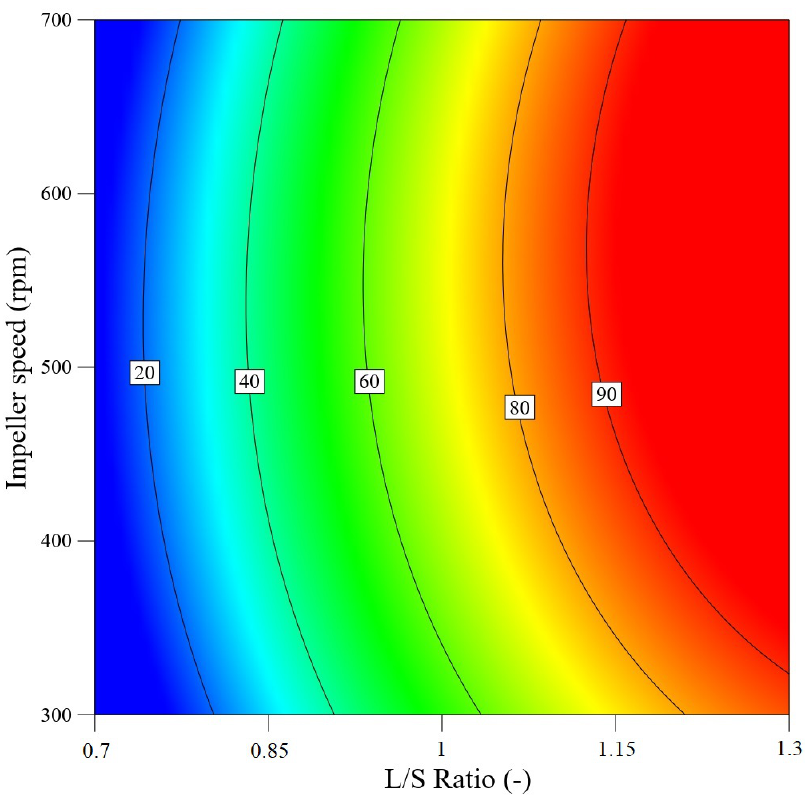
Figure 14. Contour plot of the quadratic model for prediction of the process yield as a function of L/S ratio and impeller speed. Table 3. Analysis of variance for the d mean model and individual variables.